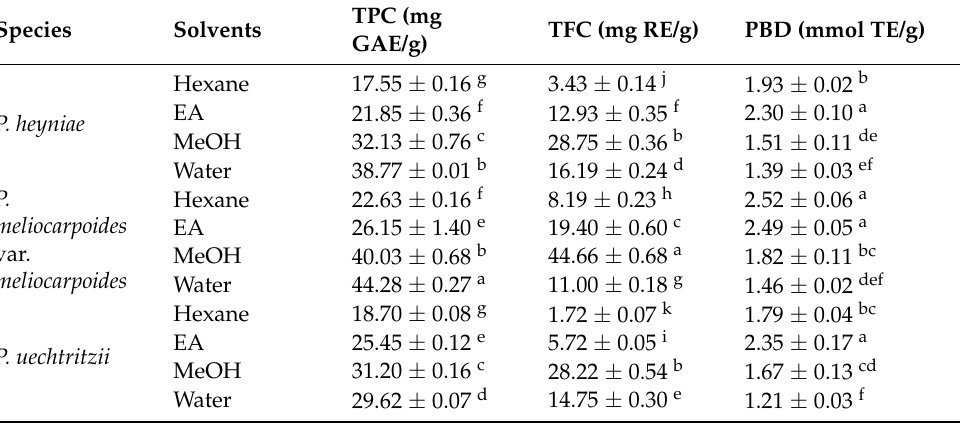
Table 1. Total bioactive compounds and total antioxidant capacity (by phosphomolybdenum assay) of the tested extracts ( n =